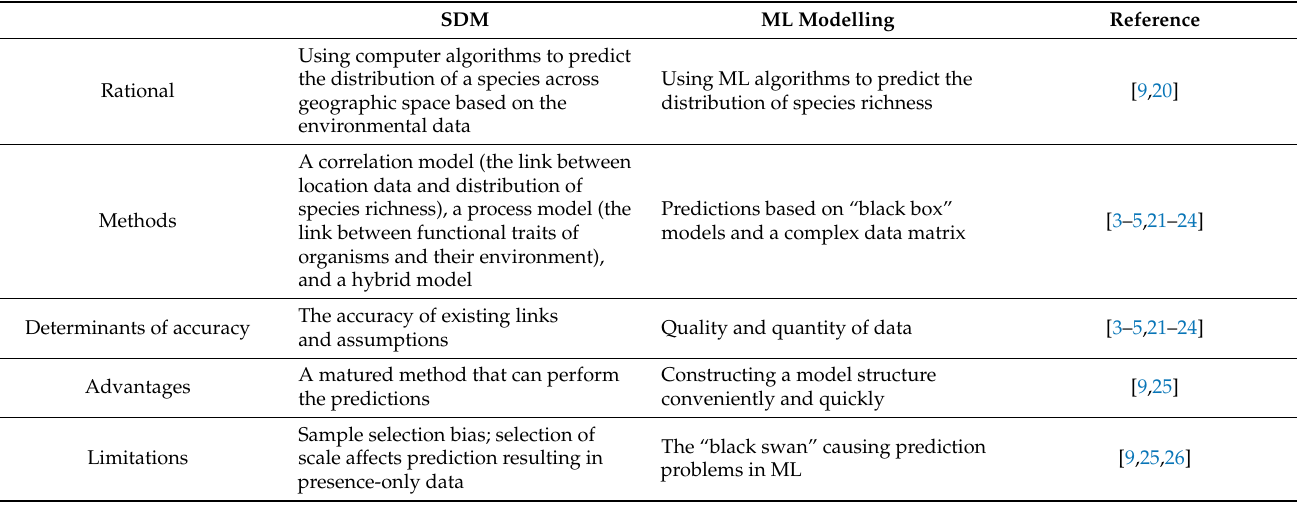
Table 1. Comparison of SDM and ML modelling.